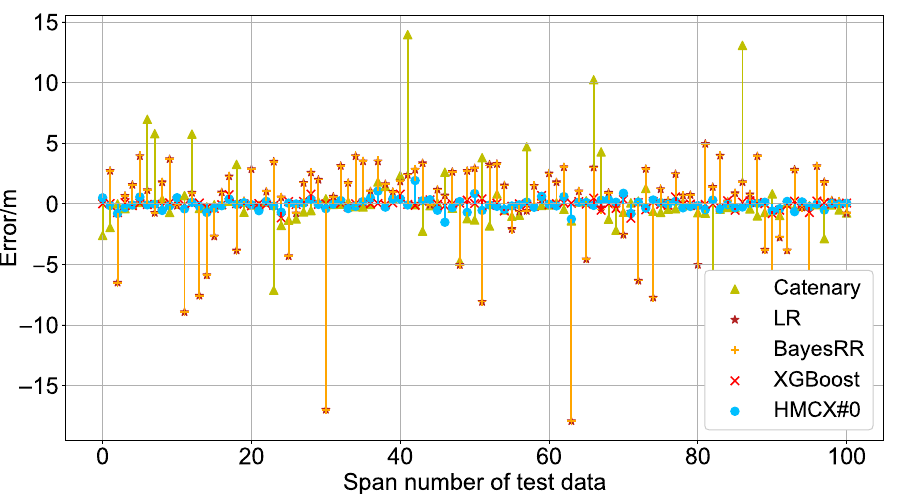
Figure 12. Sag estimation results of cluster #0.